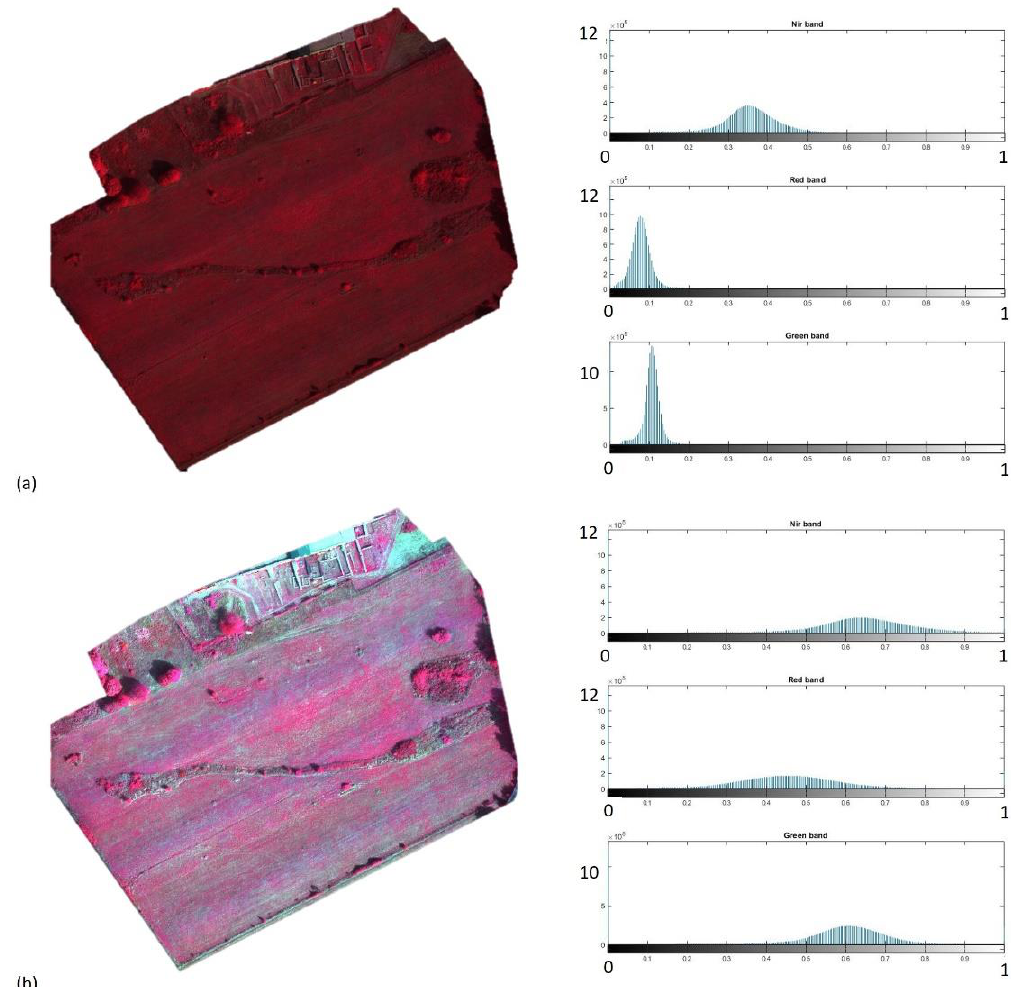
Figure 7. Example of linear enhancement techniques applied on September image: ( a ) FCIR image; ( b ) transformed FCIR image.